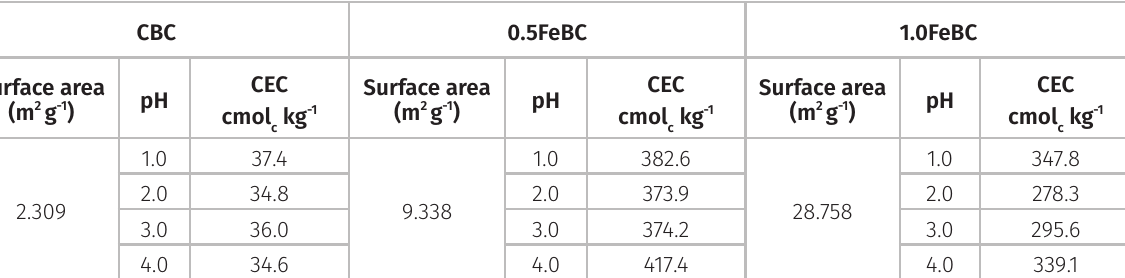
Figure 3. SEM-EDS image of (a) CBC, (b) 0.5FeBC, and (c) 1.0FeBC.